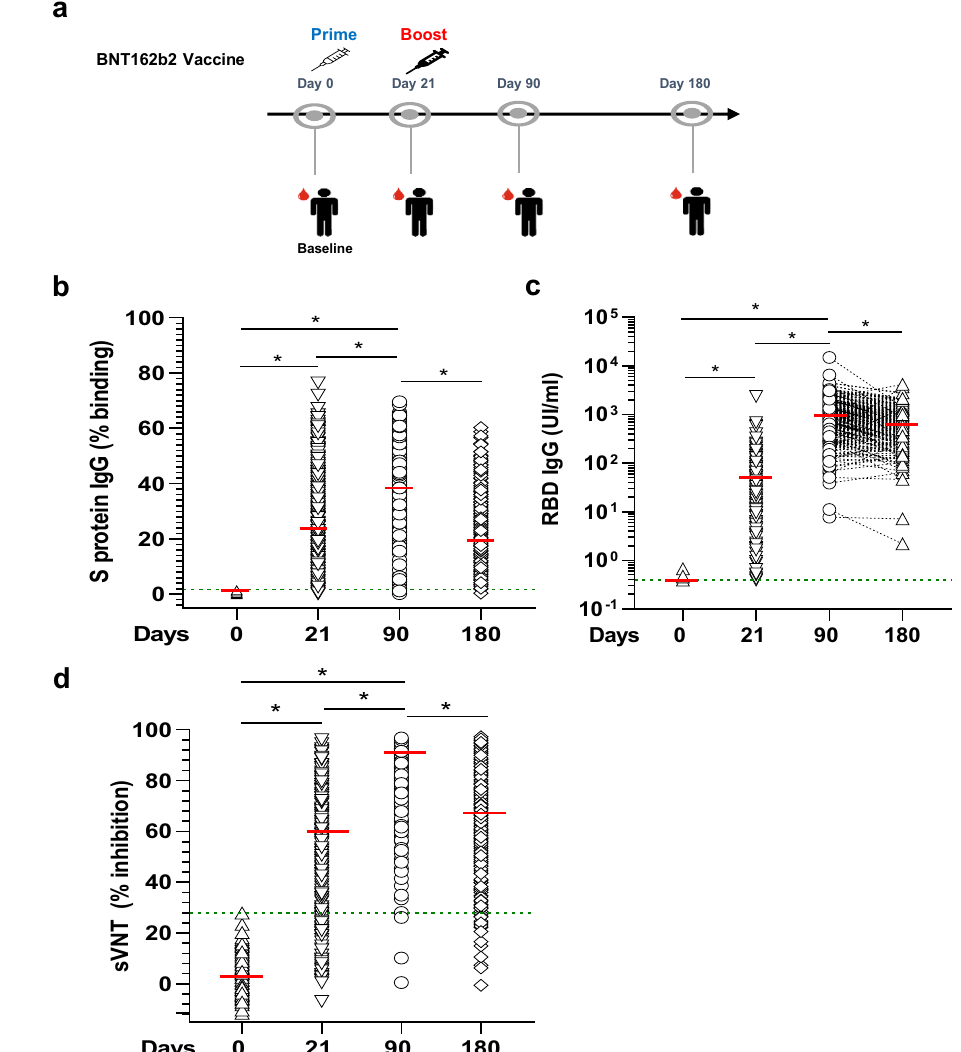
Fig. 1 | Anti-SARS-CoV-2 spike protein antibody response after vaccination. a Schematic description of the longitudinal vaccination and blood sampling strategy in a cohort of Singaporean individuals ( n =312). Kinetics of IgG response were analyzed using three serological assays on paired samples. Overall cohort baselinevalueisde fi nedasthevaluegreaterthanmaximumrangeofallsamplesin thecohort.Thegreendotted linerepresentsthemaximumrangeofthesamplesin thedifferentassays.Themedianvaluesofeachgrouparerepresentedbyaredline. b A fl ow cytometry-based assay using the full Spike protein (SFB) assay. Median (range) of values at day 0 was 0.06% (0.002, 1.7). Antibody levels below the max- imumrange(1.7%)wereconsideredbaselinevalues.Medianvalueswas28.4%atday